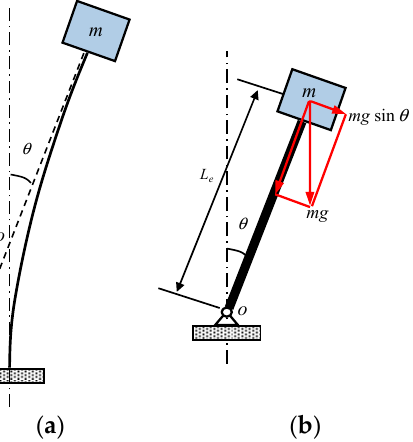
Figure 22. Bi-stable vibration model of inverted cantilever with lumped mass block at its tip. ( a ) Original vibration model. ( b ) Virtual vibration model.